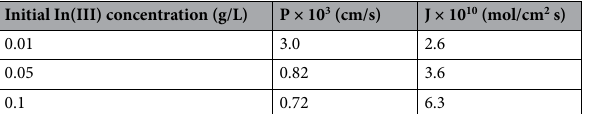
Table 2. Variation in the indium(III) permeation coefficient (P) and flux (J) with variation in the initial metal concentration in the source phase. The stirring speeds in the source and receiving phases were 750 and 500 min -1 ,